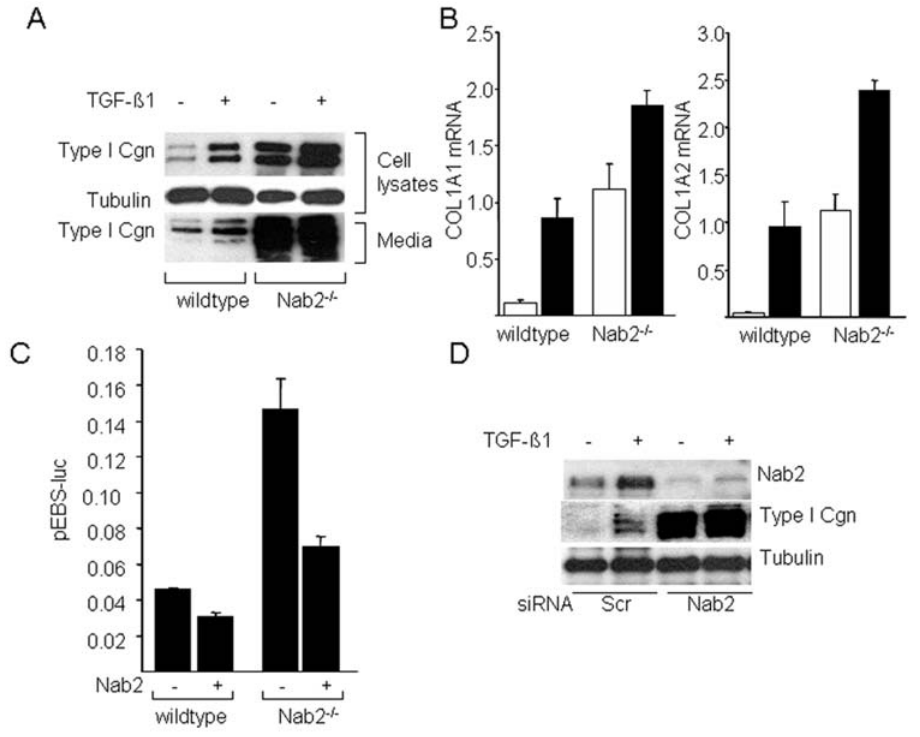
Figure 4. Enhanced collagen stimulation in Nab2-deficient fibroblasts. Wildtype and Nab2 2 / 2 mouse embryonic fibroblasts (MEFs) cultured in parallel were incubated with or without TGF- b 1 for 24 h. A . Whole cell lysates and culture supernatants were subjected to Western analysis. Representative immunoblots. B. Total RNA was subjected to real-time qPCR analysis. Results, expressed relative to 18 s, are the means 6 S.D. of triplicate determinations from a representative experiment. Open boxes, untreated fibroblasts; closed boxes, TGF- b -treated fibroblasts. *p , 0.005. C. MEFs were transfected with pEBS 4 -luc inpresence or absence of Nab2. Following 24 h incubation, cultures were harvested and cell lysates were assayed for their luciferase activities. The results, normalized with Renilla luciferase, are the means 6 S.D. of triplicate determinations. D . siRNA knockdown. Normal dermal fibroblasts were transfected with Nab2 siRNA or irrelevant negative control siRNA, and incubated with TGF- b . Twenty- four h later, fibroblasts were harvested. Levels of Nab2 and collagen were determined by Western analysis of whole cell